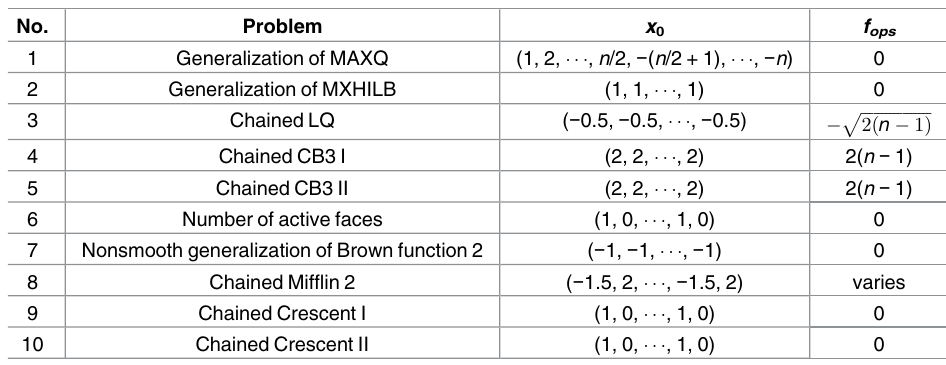
Table 1. Test problems and their initial points and optimal